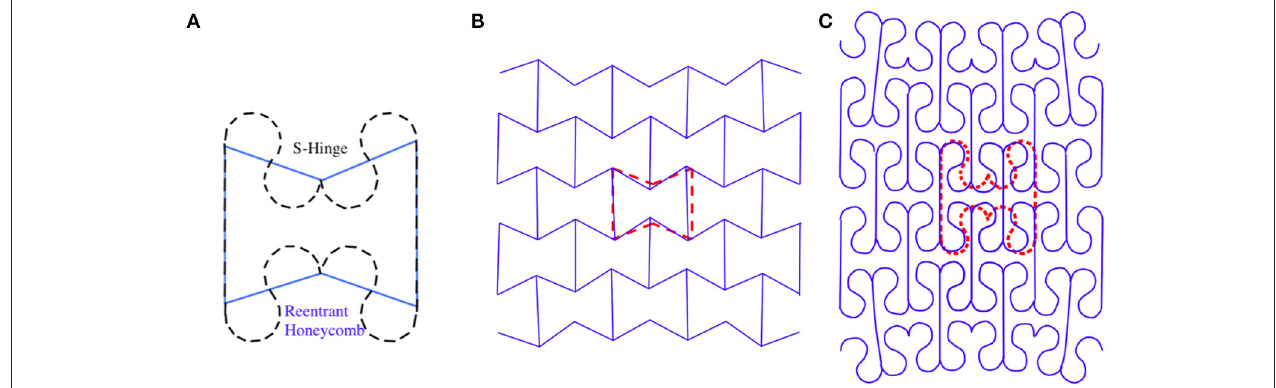
FIGURE 1 | Fabrication of s-hinged unit cell into a 2D and 3D auxetic material. (A) S-hinged unit cell (dashed) overlaid on comparison of a reentrant honeycomb unit cell (solid blue). (B) Compressed reentrant honeycomb auxetic with outline of original cell, stresses concentrate at vertices. (C) Compressed s-hinged auxetic (made from 225-degree arc length) with outline of original cell, stresses distribute with deformation of the whole